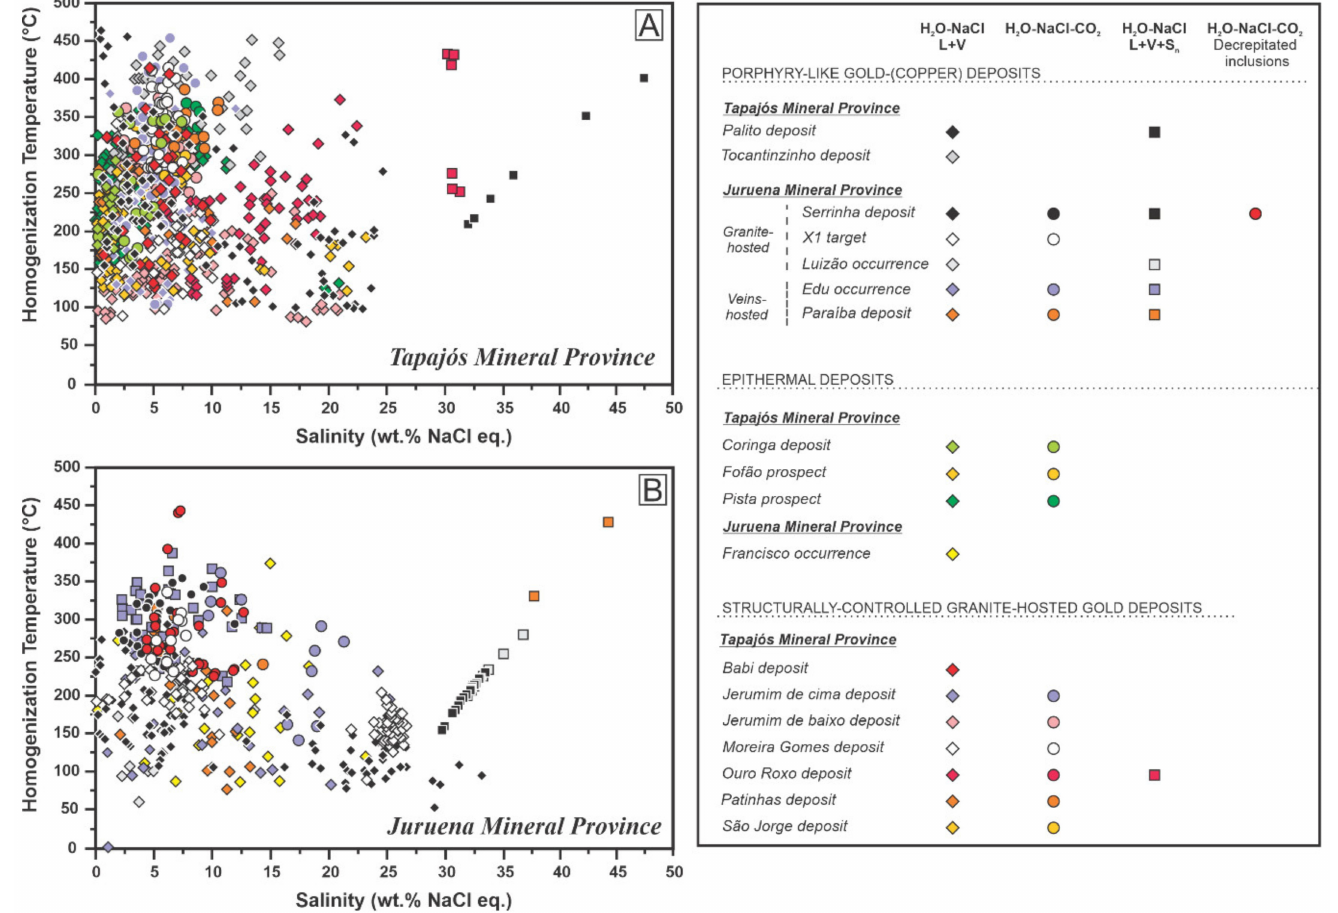
Figure 6. Homogenization temperatures and salinities of aqueous (H 2 O–NaCl) and aqueous–carbonic (H 2 O–NaCl–CO 2 ) fluid inclusions trapped in quartz from the gold-(polymetallic) deposits, prospects, and occurrences of the TMP ( A ) and JMP ( B ). Data source: TMP—[9,24,28,66,90,101,105,107–110];